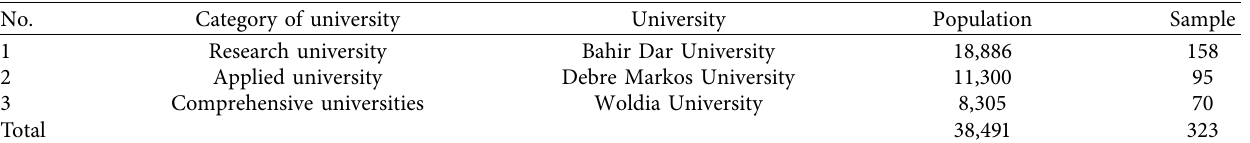
Table 1: Sample size